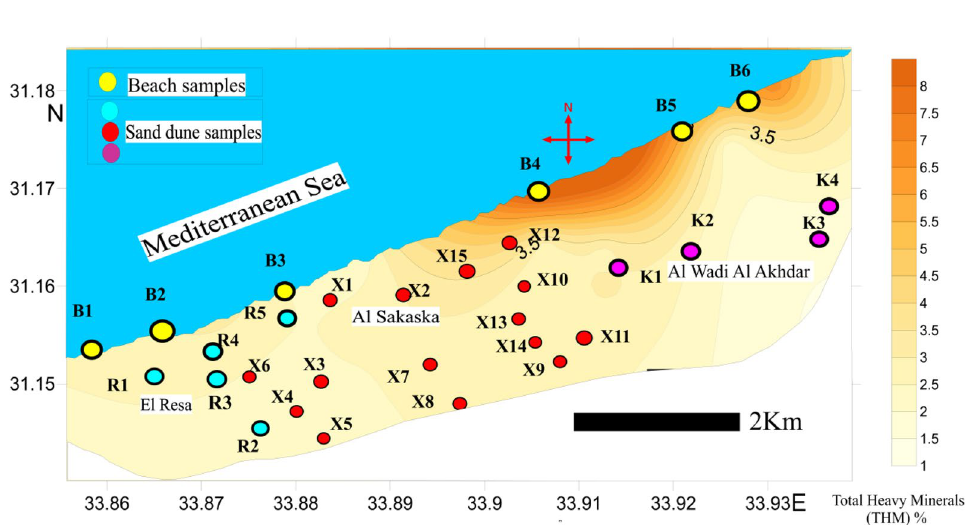
Figure 5. Contour map shows the total heavy minerals distribution. Map was created by Surfer Software 13.6 (2016). https:// www. golde nsoft ware. com/ produ cts/